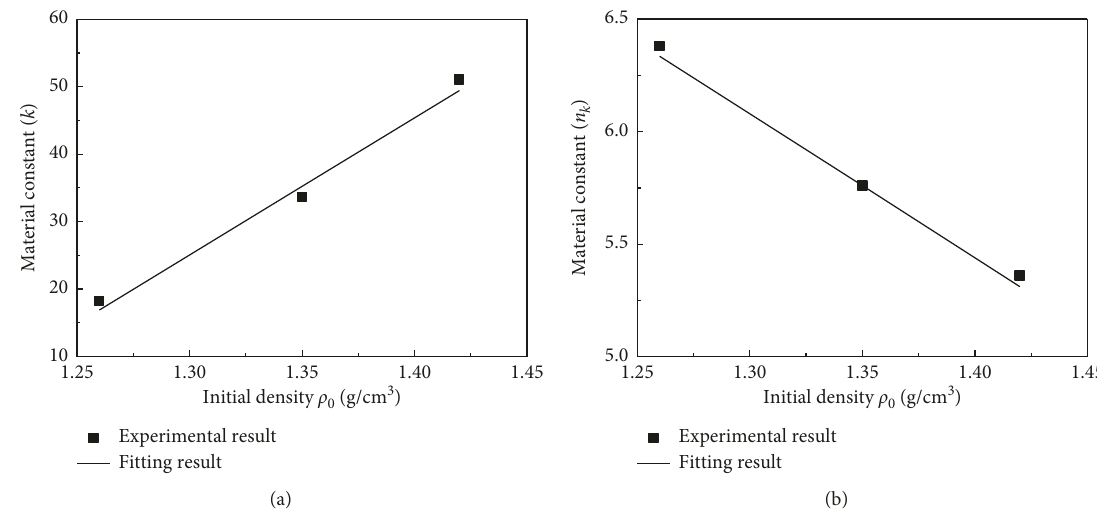
Figure 13: Relationship between material constants and initial density of the sample. (a) Material constant k . (b) Material constant n